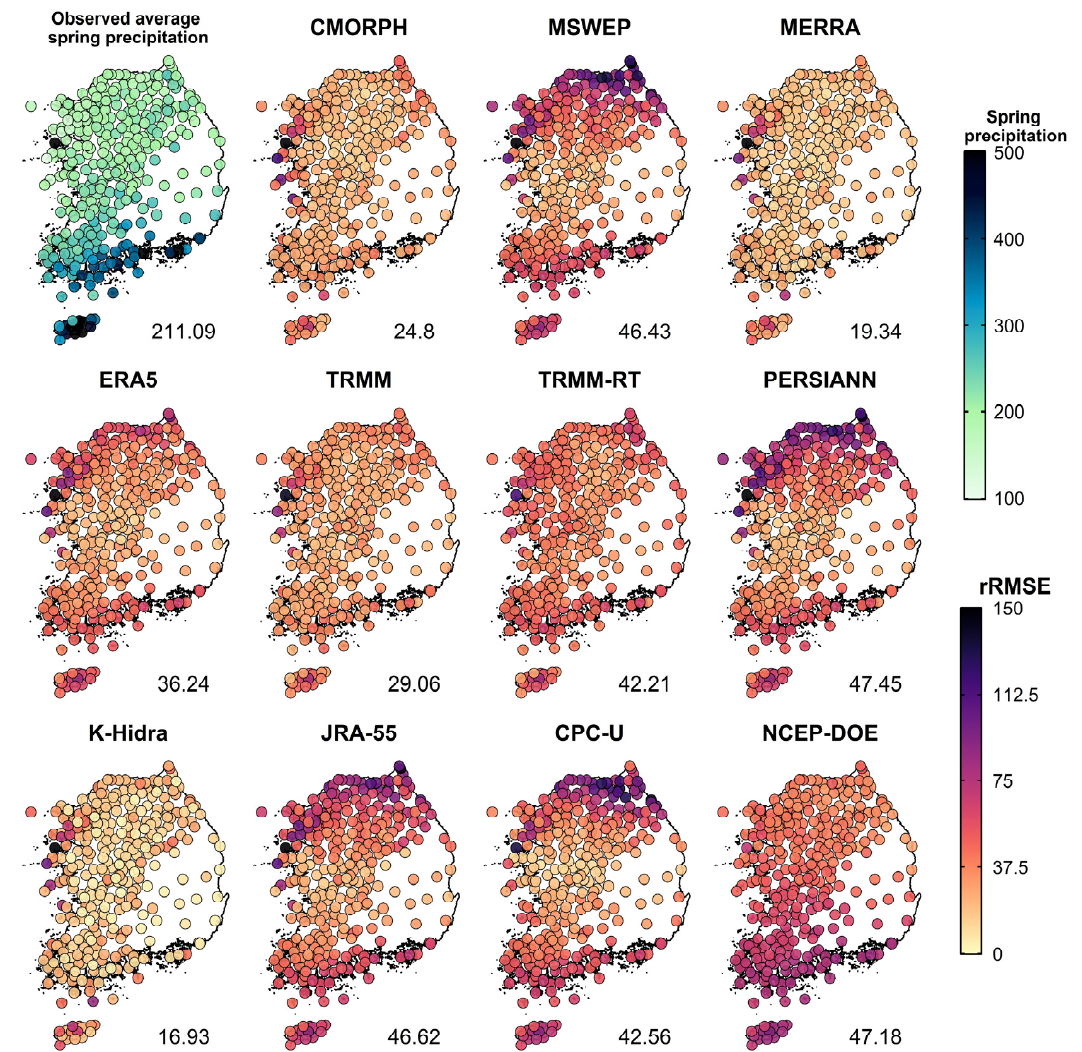
Figure 4. Spatial patterns of rRMSE for spring (MAM) precipitation of the grid datasets from observations. The median values of rRMSE metric across 356 stations are also presented for each sub-figure.